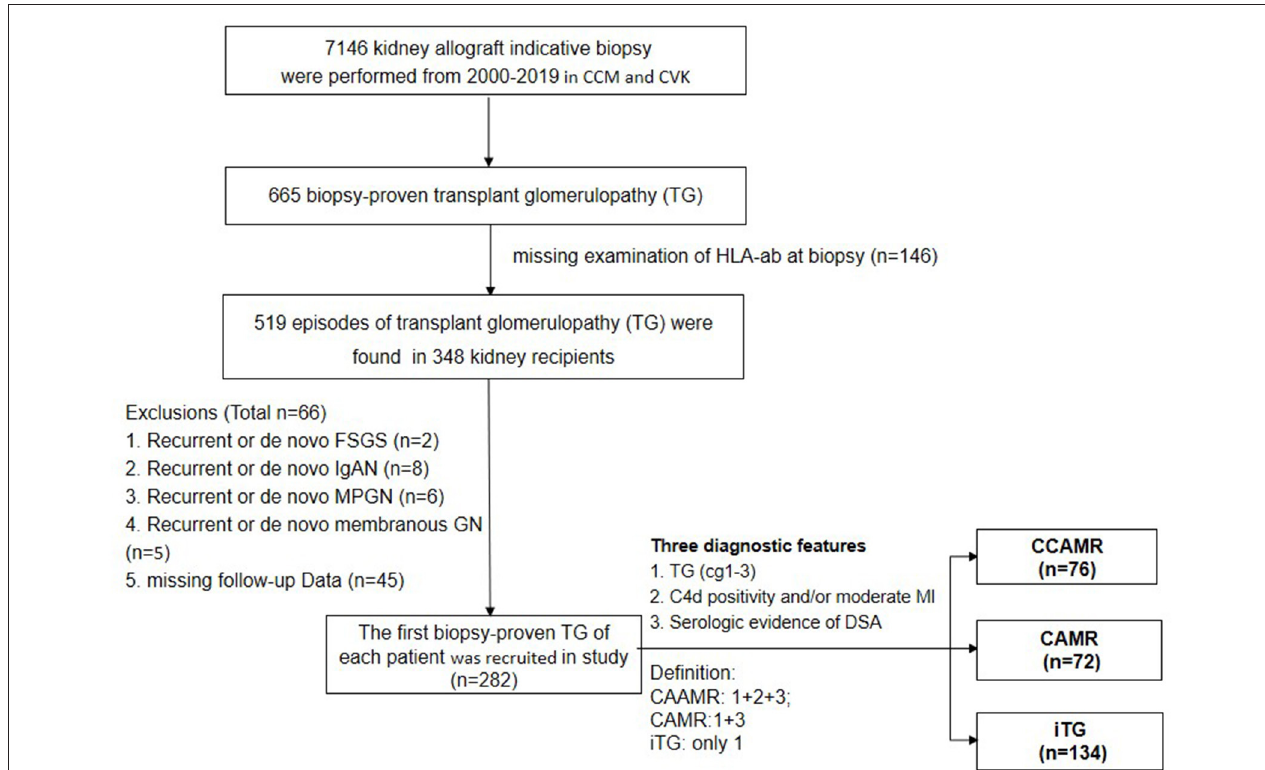
FIGURE 1 | Flow chart of patients enrolled in this study. CCM, Charite Campus Mitte; CVK, Charite Virchow Klinikum. FSGS, focal segmental glomerulosclerosis; IgAN, IgA nephropathy; PGN, membranous proliferative glomerulonephritis; membranos GN, membranous glomerulopathy; iTG, solated transplant glomerulopathy; cAMR, chronic antibody-mediated rejection; cAAMR, chronic active antibody-mediated